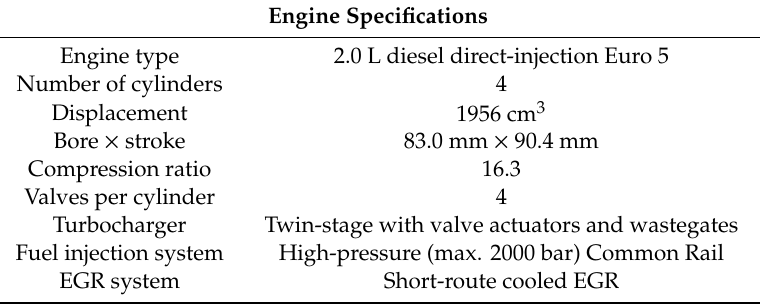
Table 1. Main technical specifications of the engine adopted for the experimental